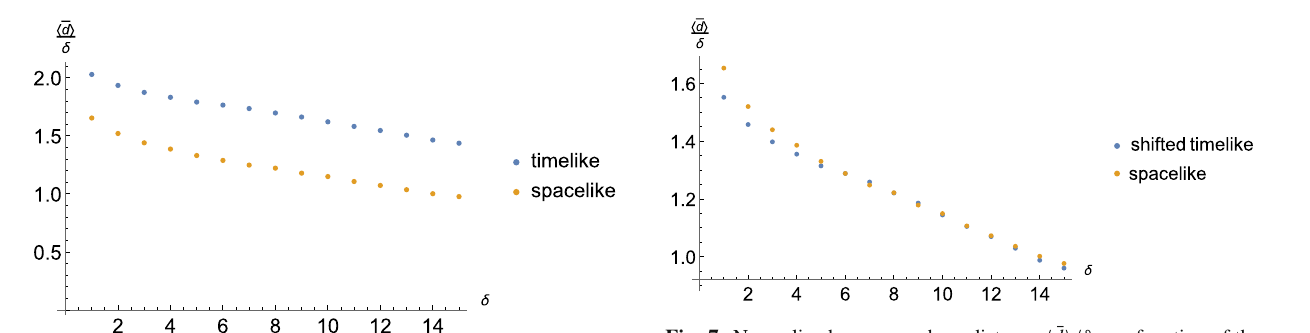
Fig. 7 Normalized average sphere distance (cid:2) ¯ d (cid:3) /δ as a function of the duallinkdistance δ atvolume N 41 = 150 k .ComparedtoFig.6,thedata points for the maximally timelike separated spheres have been shifted along the vertical axis by − 0 . 476 to make the two data sets agree at δ =